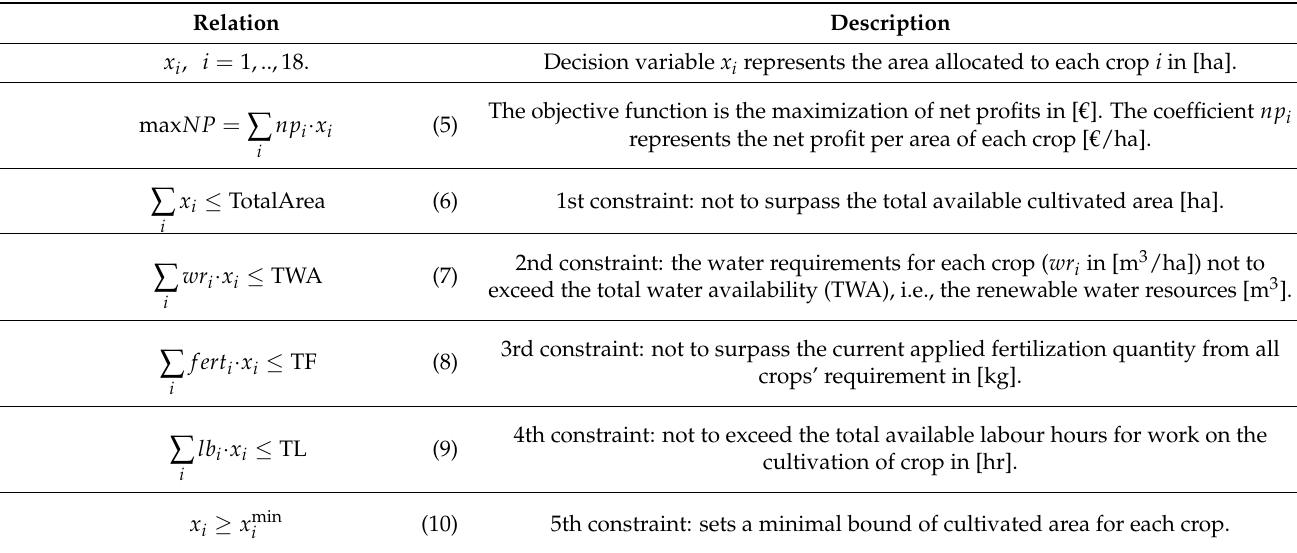
Table 1. Mathematical description of the LKW model (annual values). Relation